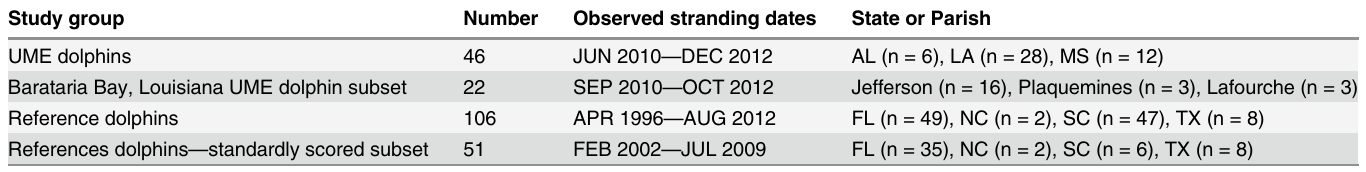
Table 1. Total number, stranding dates, and locations of 152 freshly dead stranded non-perinatal (greater than or equal to 115 cm in total body length) common bottlenose dolphins ( Tursiops truncatus ) from the ongoing northern Gulf of Mexico cetacean Unusual Mortality Event (UME) and reference